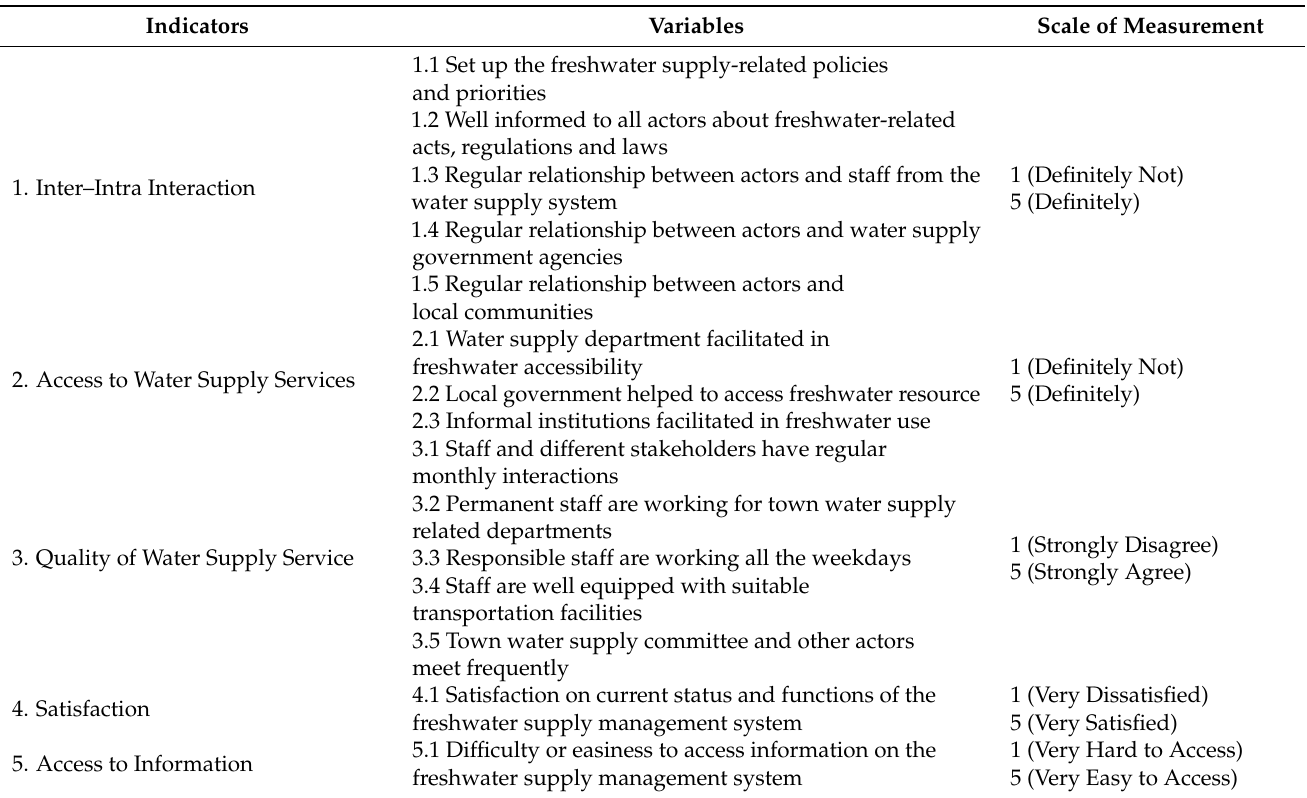
Table A1. Indicators and variables used in the structured interviews and surveyed questionnaires for meas-uring stakeholders’ perceptions of water supply